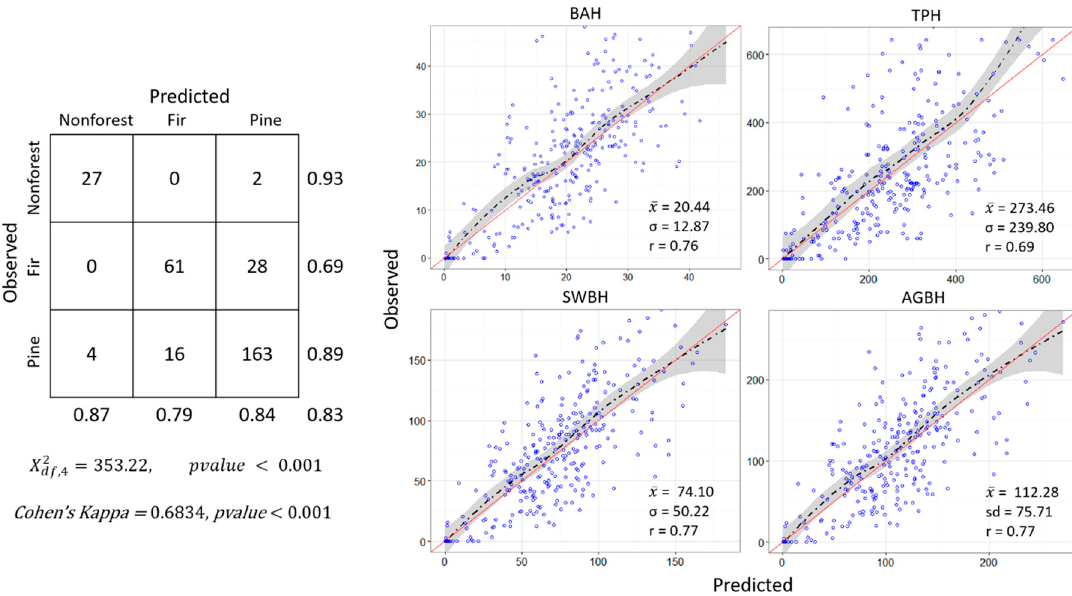
Figure 7. Accuracy assessment with user, producer, and overall accuracies, chi-squared ( X 2 ) statistics, and Cohen’s Kappa statistics for the most likely DomType class (left) and general trends between observed and predicted values for basal area ha − 1 (BAH), trees ha − 1 (TPA), stem woody biomass ha − 1 (SWBH), and above ground biomass ha − 1 (AGBH). For BAH, TPH, SWBH, and AGBH graphics, a loess trend line (black dashed) and corresponding 99% confidence region (grey region) around that line were overlaid with a linear 1 to 1 trend line (red line) to visually aid in evaluating model fit. Additionally, the mean ( 𝑥̅ ) and standard deviation ( σ ) of observed values and Pearson’s correlation coefficient (r) comparing observed and predicted values are reported in the bottom right corner of BAH, TPH, SWBH, and AGBH graphics.